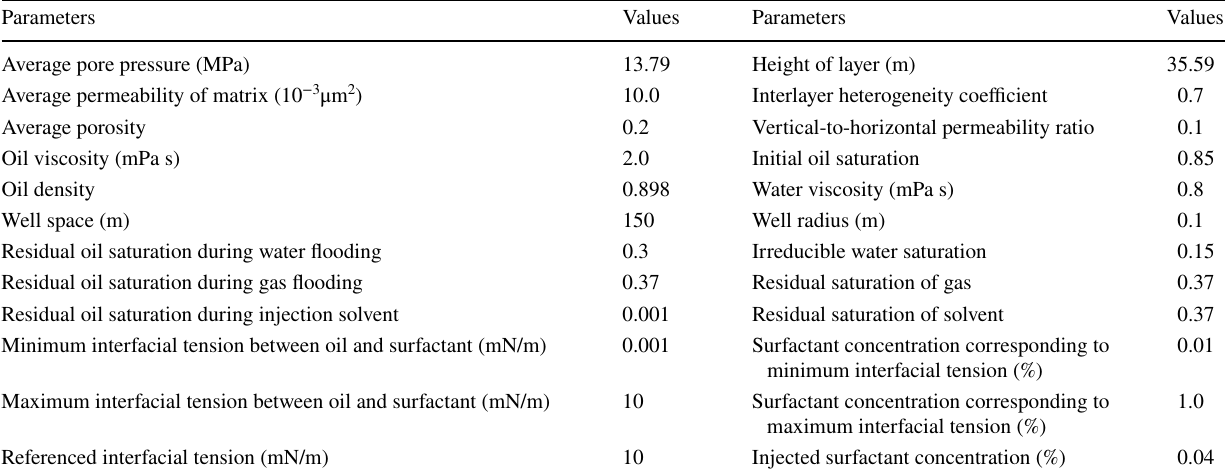
Table 2 Basic parameters for numerical simulation